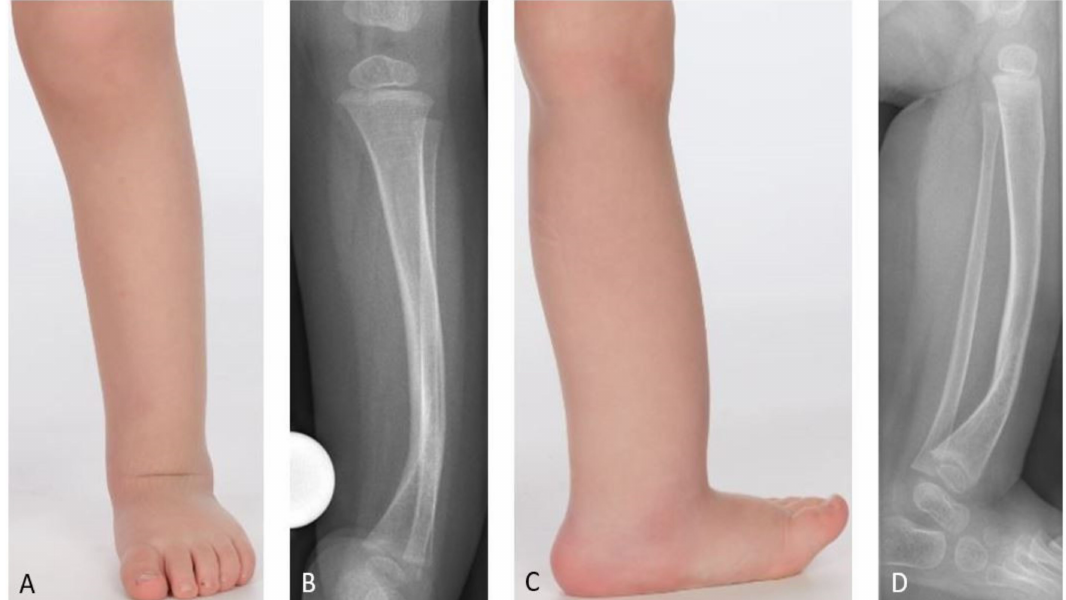
Figure 1. Clinical and radiological presentation of anterolateral bowing in congenital pseudarthrosis of the tibia (CPT); ( A , B ) anterior-posterior (a.p.) view; ( C , D ) lateral